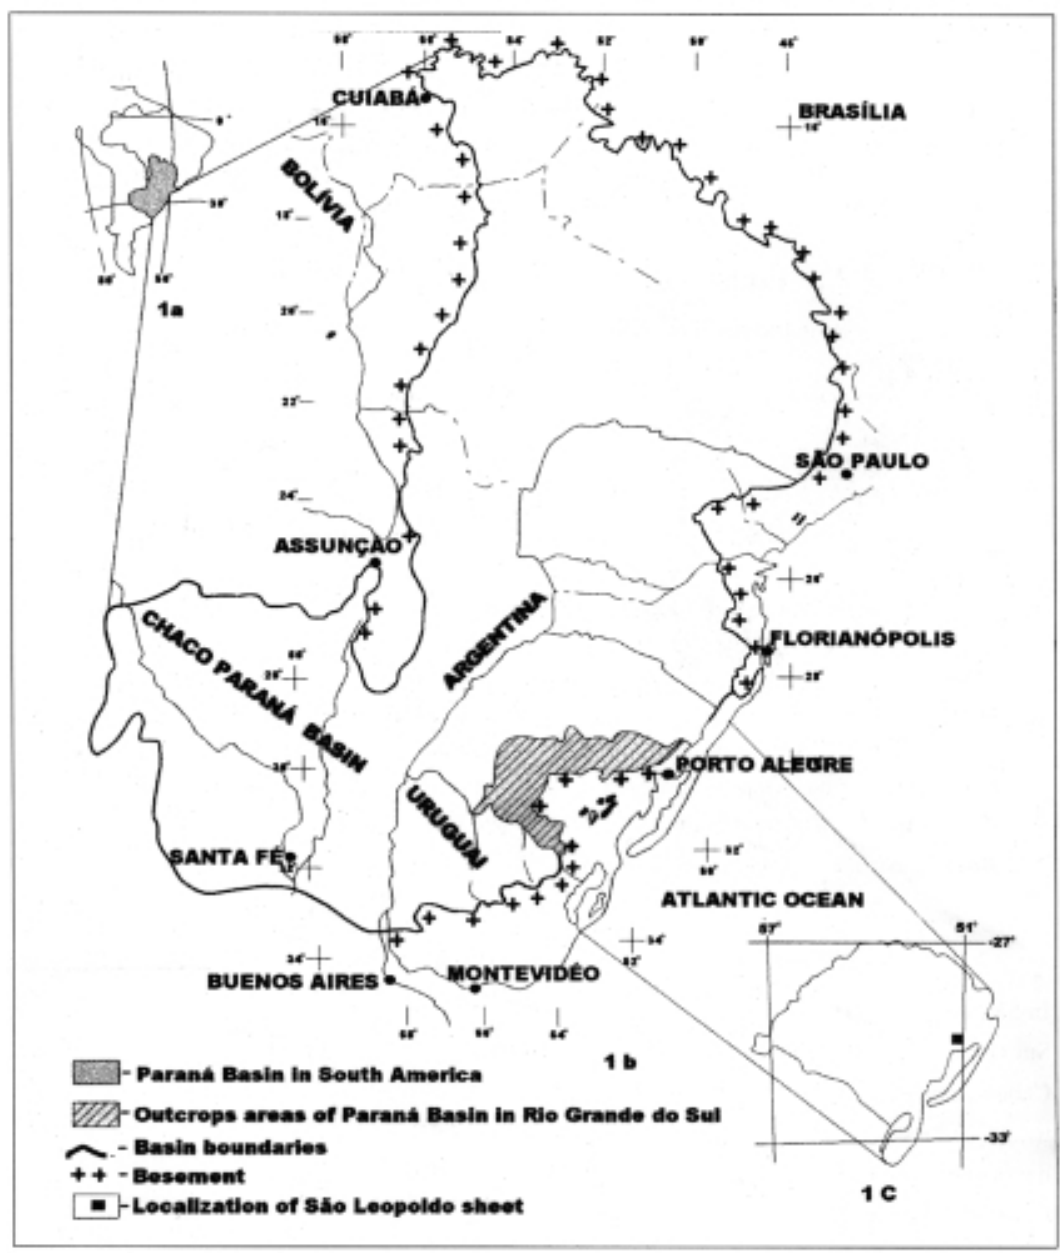
Fig. 1 – a. Position of the Paraná Basin in South America; b. Area occupied by the Paraná Basin in Brazil, Argentina, Uruguay and Paraguay; c. Localization of the studied area in the State of Rio Grande do Sul (according to Zalán et al. 1987,